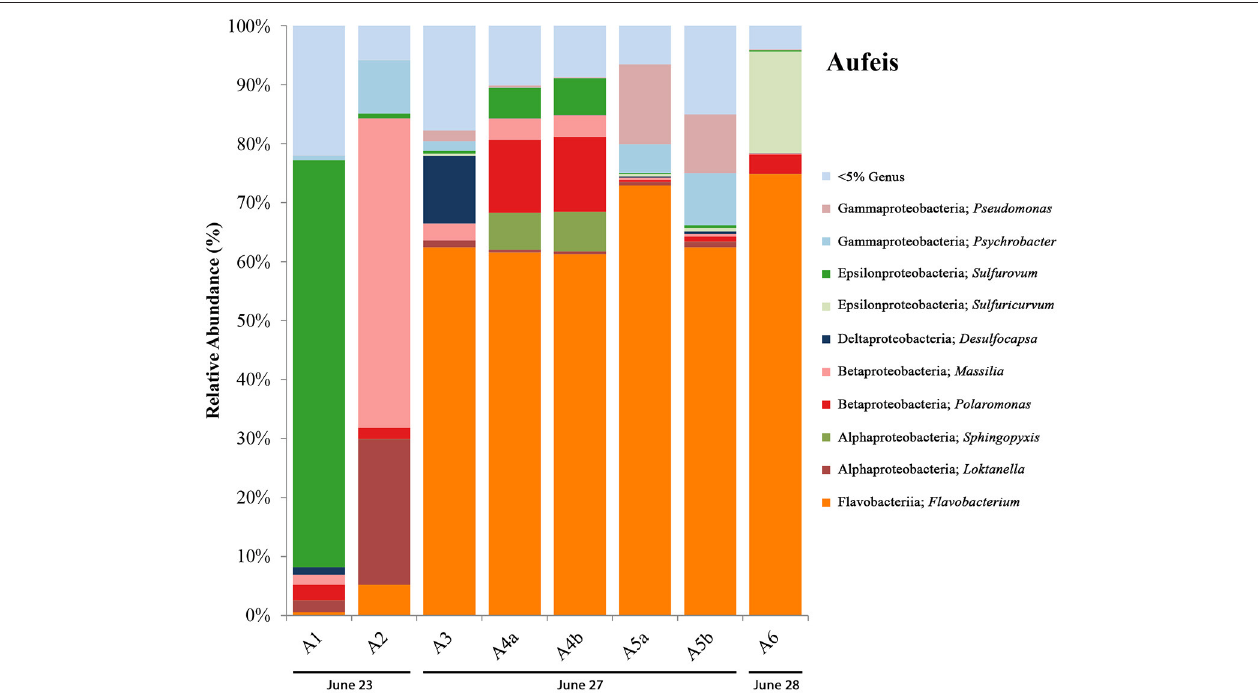
FIGURE 4 | Aufeis bar charts show relative abundance of 16S rRNA gene sequencing libraries, where only OTUs representing organisms more than 5% of any given sample are labeled. All other OTUs below 5% relative abundance are grouped together in the category “Genus < 5%.” Labels show Class and subsequent Genus level. Sites are named such that any biological replicates are denoted by lowercase letters. Aufeis samples are in order (from left to right) according to date sampled. Their order as they appear in the Sulfidic Aufeis zone can be seen in Figure